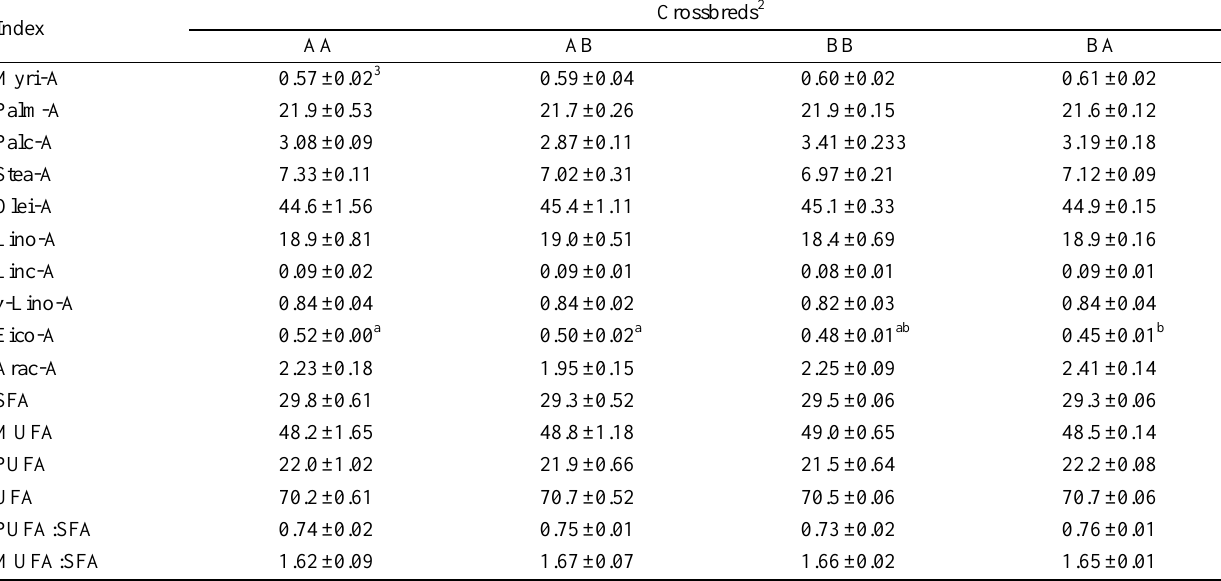
Table 9. Fatty acid composition (%) of breast meat of commercial Korean native ducks